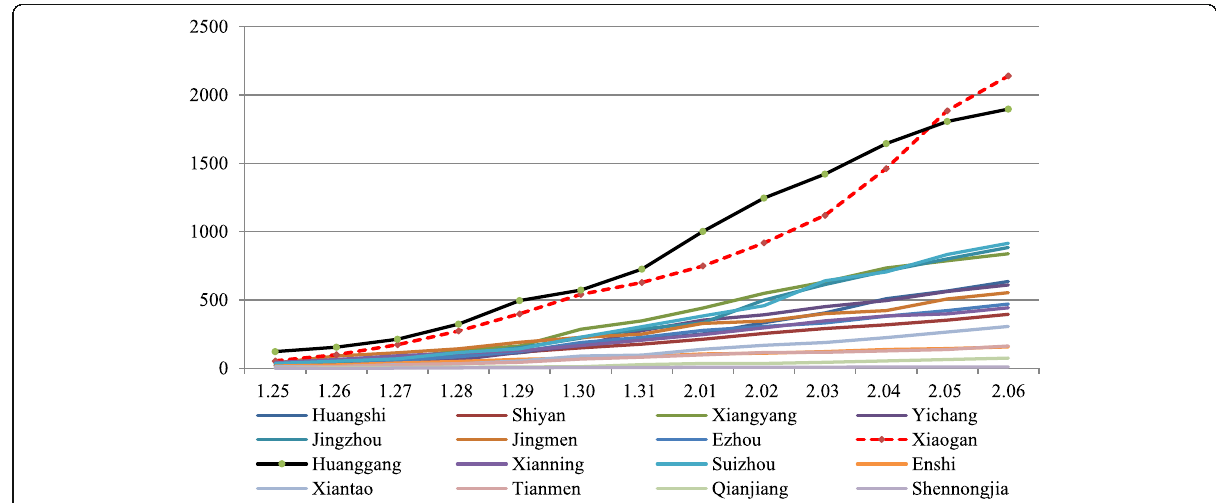
Fig. 1 Cumulative number of confirmed COVID-19 cases in 16 prefecture-level cities in Hubei Province from January 25th to February 6th,